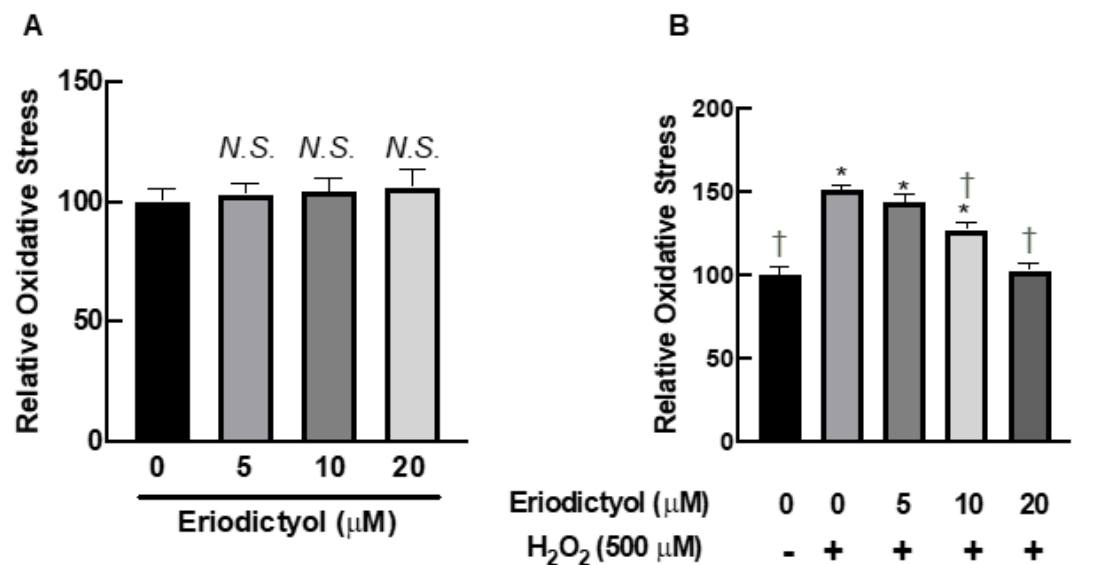
Figure 3. Eriodictyol inhibited oxidative stress in BJ cells following H 2 O 2 exposure. ( A ) Eriodictyol treatment (5–20 µ M; 24 h) did not alter the redox status of BJ cells. ( B ) Eriodictyol pretreatment (10–20 µ M; 24 h) inhibited H 2 O 2 -induced oxidative stress (500 µ M; 1 h) in a concentration-dependent fashion. Oxidative stress was immediately evaluated using the DCFH-DA assay after the indicated treatments. Relative oxidative stress was calculated compared with that in untreated controls. DMSO (0.5%) was used as a vehicle control ( n = 3; each biological replicate consisted of three independent wells; mean ± SEM). * p < 0.05 versus untreated controls; † p < 0.05 versus H 2 O 2 -treated cells. N.S. , not